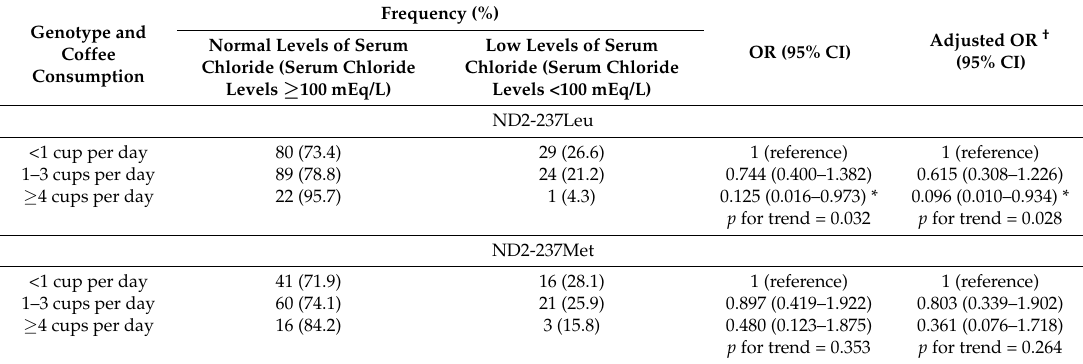
Table 3. Odds ratios (ORs) and 95% confidence intervals (CIs) for low levels of serum chloride